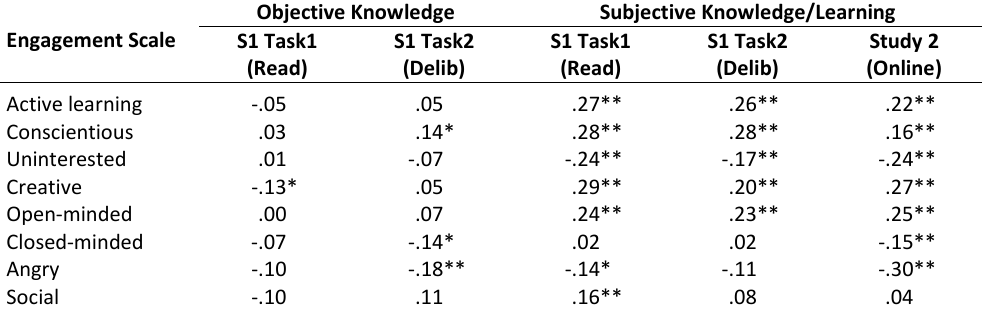
Table 8. Correlations between Engagement Factors and Post-Knowledge Variables Objective Knowledge Subjective Knowledge/Learning Engagement Scale S1